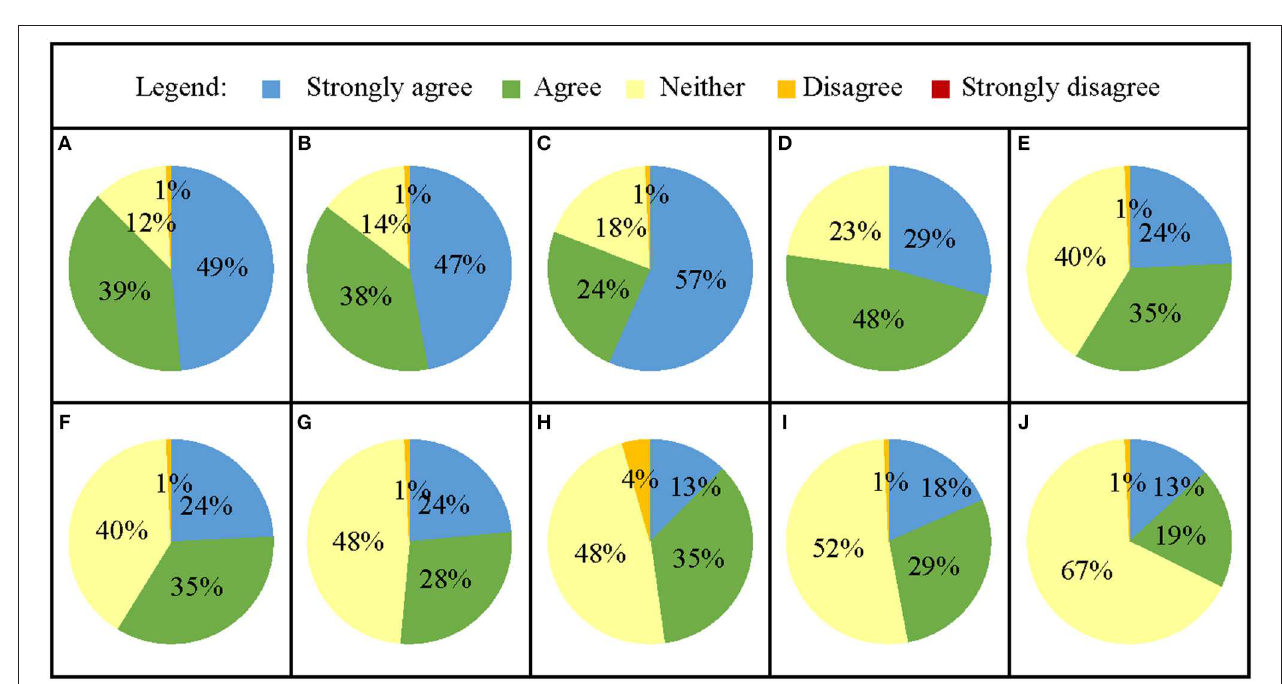
FIGURE 12 | Consumer knowledge and perceptions of health. Total informant level of agreement with health and nutritional statements regarding the effects of including lentils in their diet to help (A) improve nutrition ( p < 0.0001), (B) feel satiated or full ( p < 0.0001), (C) support plant-based diets ( p < 0.0001), (D) promote a healthy digestive track ( p < 0.0001), (E) maintain healthy blood sugar ( p < 0.0001), (F) benefit weight loss efforts ( p = 0.0035), (G) lower bad cholesterol ( p = 0.0006), (H) produce gas ( p = 0.0395), (I) benefit diet of those with diabetes ( p = 0.0007), and (J) reduce cancer risk ( n = 138). Significant differences are between lentils consumers and non-consumers ( n =